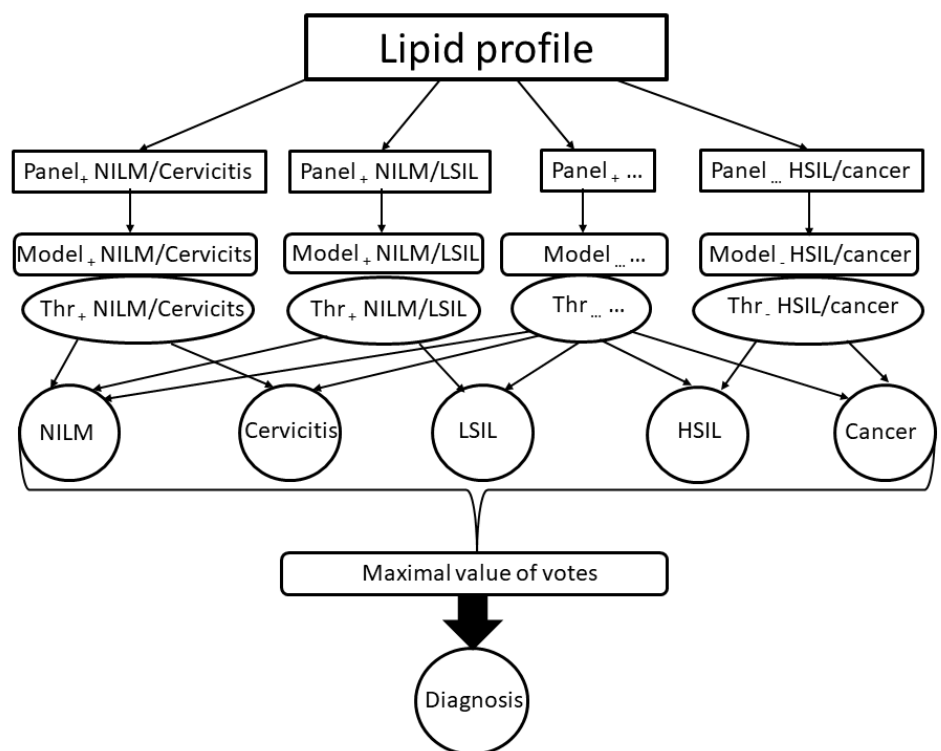
Figure 1. The structure of the final diagnostic model. Panel x D1/D2 indicate lipids included in the logistic regression to discriminate diagnosis D1 from diagnosis D2 in the x ion mode; Model x D1/D2 indicate model based on logistic regression to discriminate diagnoses D1 and D2 in the x ion mode, Thr x D1/D2 indicate a threshold of a logistic regression result to set a D1 or D2 diagnosis.